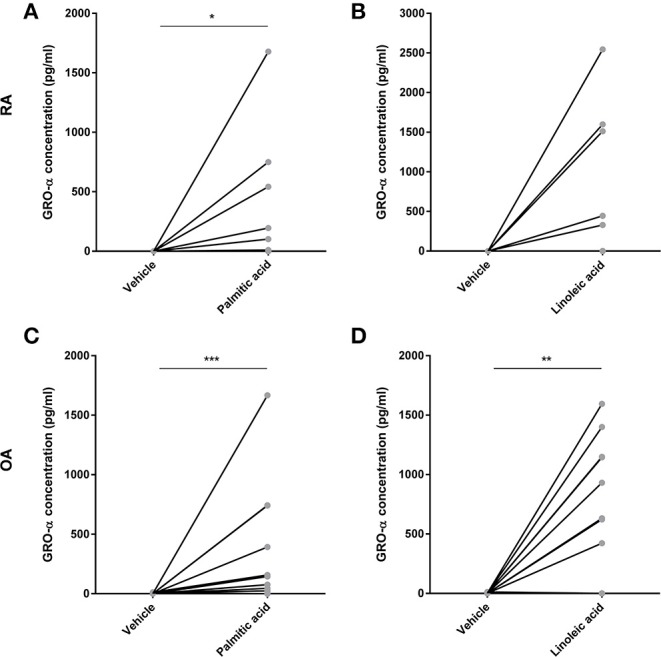
Free fatty acids palmitic acid and linoleic acid induce the secretion of the chemokine GRO-α in osteoblasts. GRO-α was induced from a non-detectable level in RA (A,B, n = 14) and OA (C,D, n = 20) in a subset of osteoblast populations. *p < 0.05; **p < 0.001; and ***p < 0.001. GRO-α, Growth-related oncogene α (CXCL1).